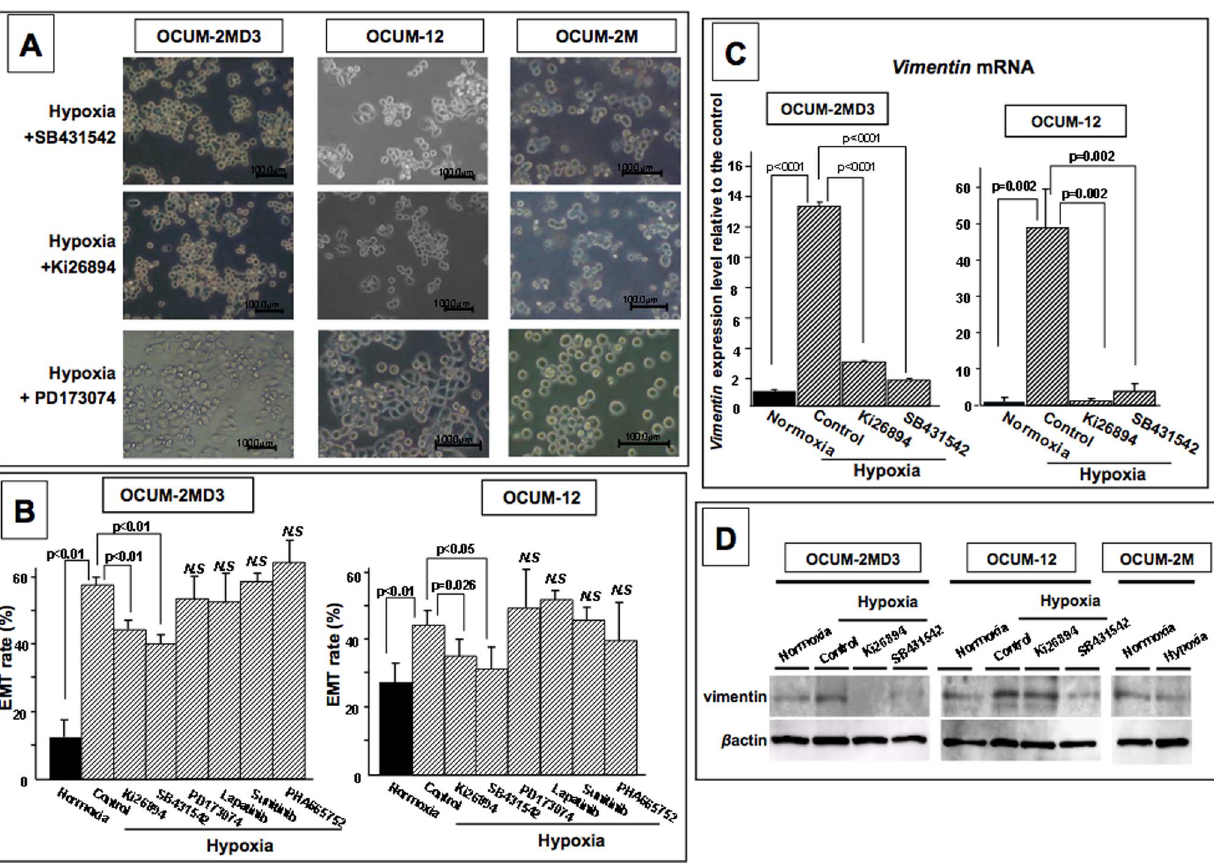
Figure 5. Effects of inhibitors on EMT under hypoxic condition. (A, B) Hypoxia-induced EMT was significantly (p , 0.01) inhibited by TGF b R inhibitors (Ki26894 and SB431542). Other inhibitors (Lapatinib, Sunitinib, and PHA665752) had no effect on EMT under hypoxia. (C) Vimentin mRNA expression was significantly increased under a hypoxic condition in OCUM-2M and OCUM-12 cells, and decreased with TGF b R inhibitors (Ki26894 and SB431542). (D)Vimentin protein was increased under hypoxia in OCUM-12 and OCUM-2MD3, and decreased with TGF b R inhibitors (Ki26894 and SB431542).